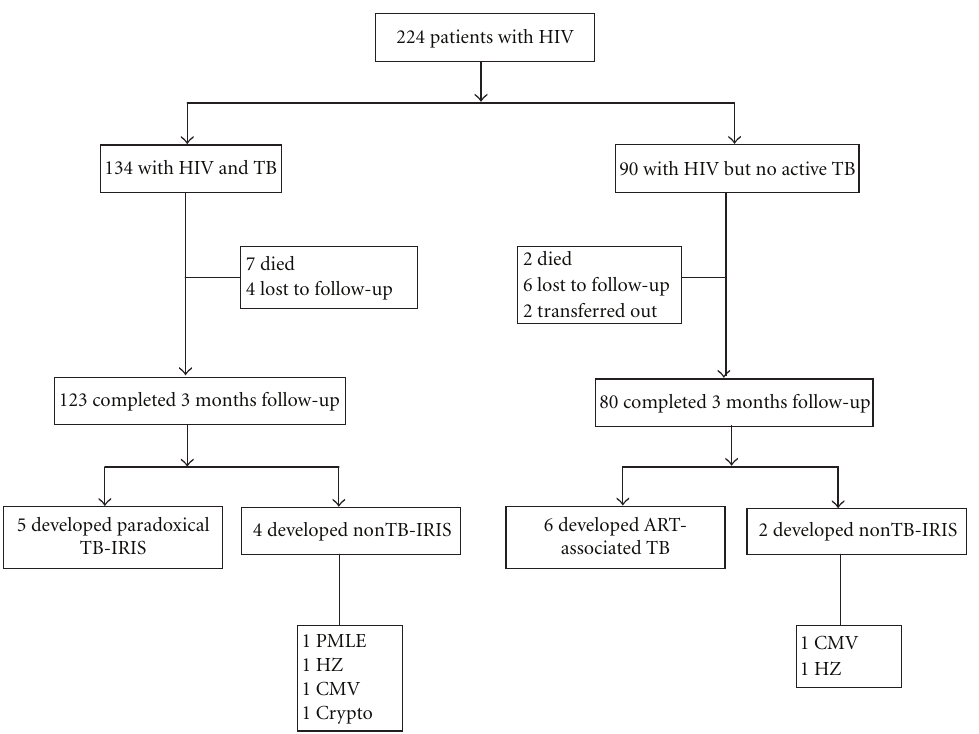
Figure 1: Study profile. HIV: human immunodeficiency virus; TB: tuberculosis; IRIS: immune reconstitution inflammatory syndrome; PMLE: progressive multifocal leukoencephalopathy; HZ: herpes zoster; CMV: cytomegalovirus; Crypto: cryptococcal